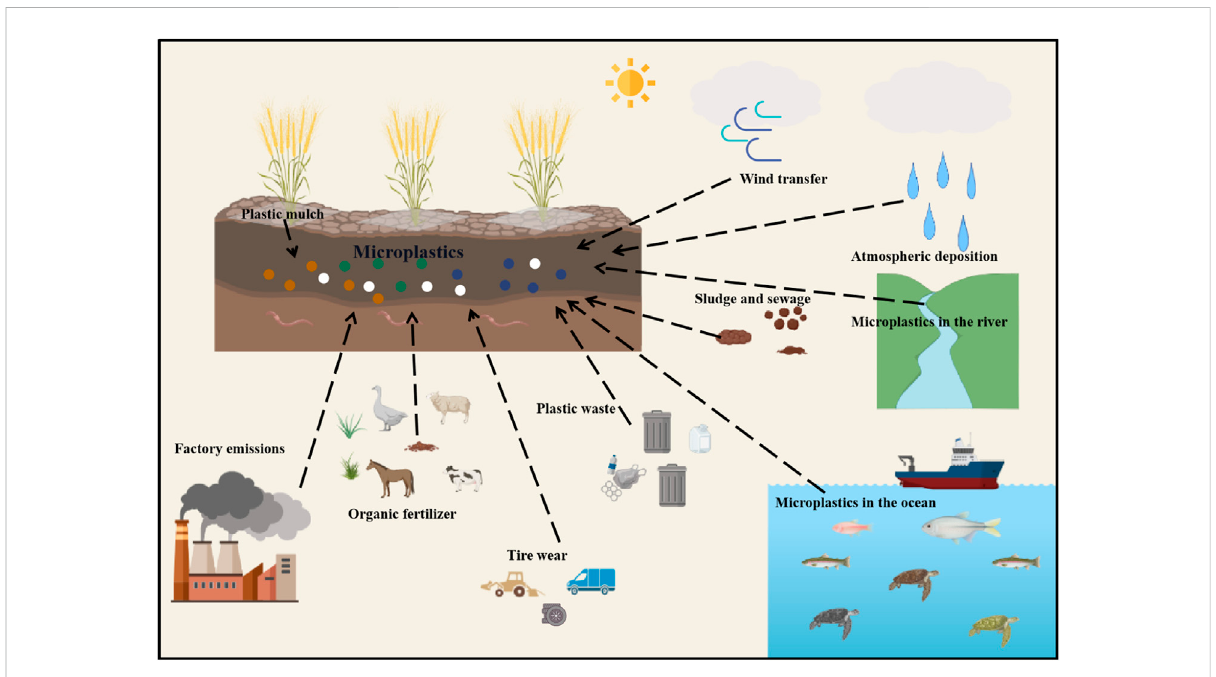
FIGURE 3 Sources of health risks from soil microplastics.(MPs in soil mainly come from agricultural mulch fi lm, plastic waste, sludge, and sewage discharged from factories, organic fertilizers applied on farmland, atmospheric deposition, fi ne particles from road tire wear, and the migration of plastic debris in oceans and